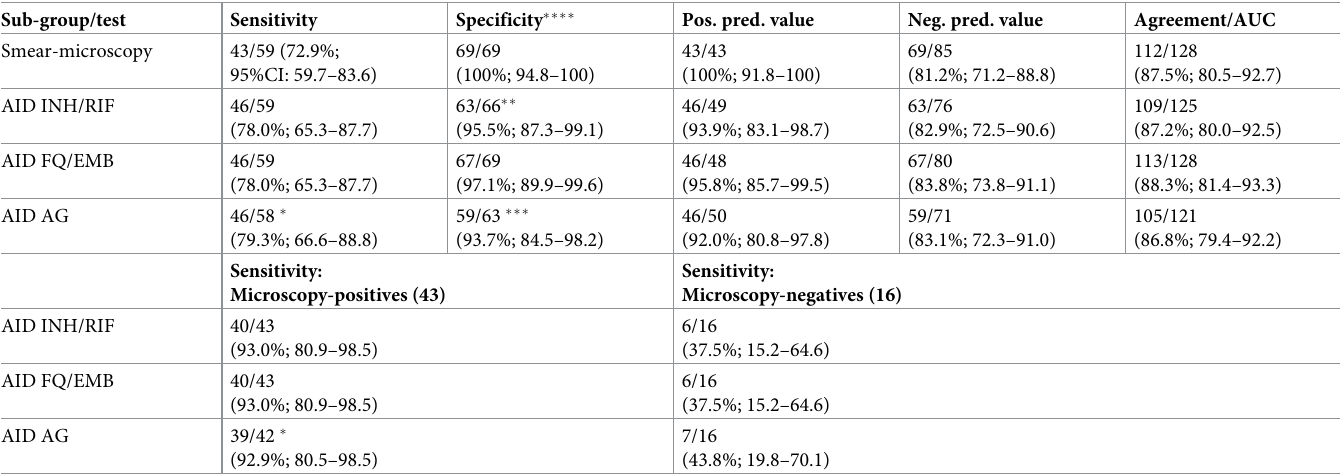
Table 2. A: Diagnostic performance of smear microscopy and different AID modules for detection of M . tuberculosis . B: Diagnostic sensitivity of different AID mod- ules in participants with culture-confirmed TB, stratified by smear-microscopy status.